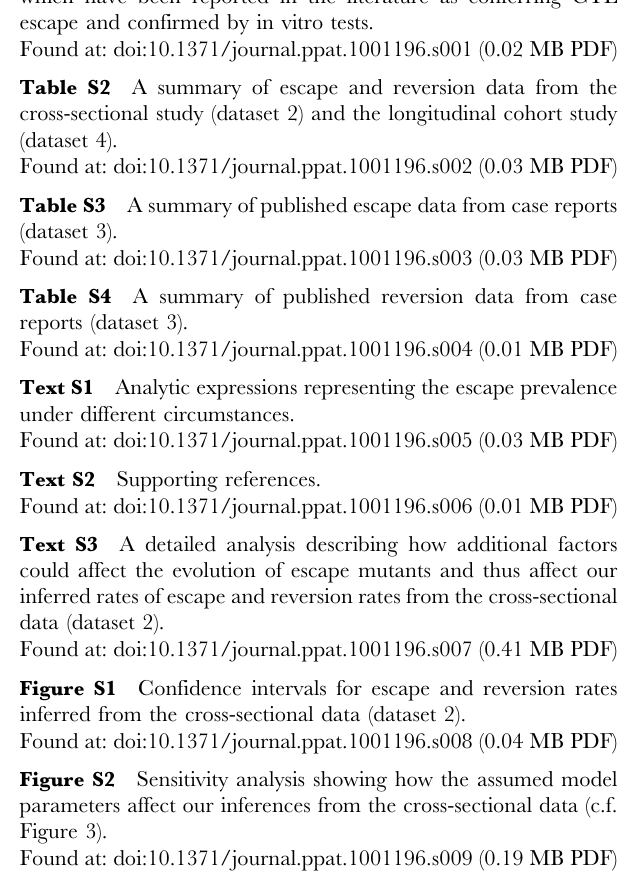
Table S1 A summary of mutations in HIV-1 gag, RT and nef which have been reported in the literature as conferring CTL escape and confirmed by in vitro tests. Table S2 A summary of escape and reversion data from the cross-sectional study (dataset 2) and the longitudinal cohort study (dataset 4). Table S3 A summary of published escape data from case reports (dataset 3). Table S4 A summary of published reversion data from case reports (dataset 3).